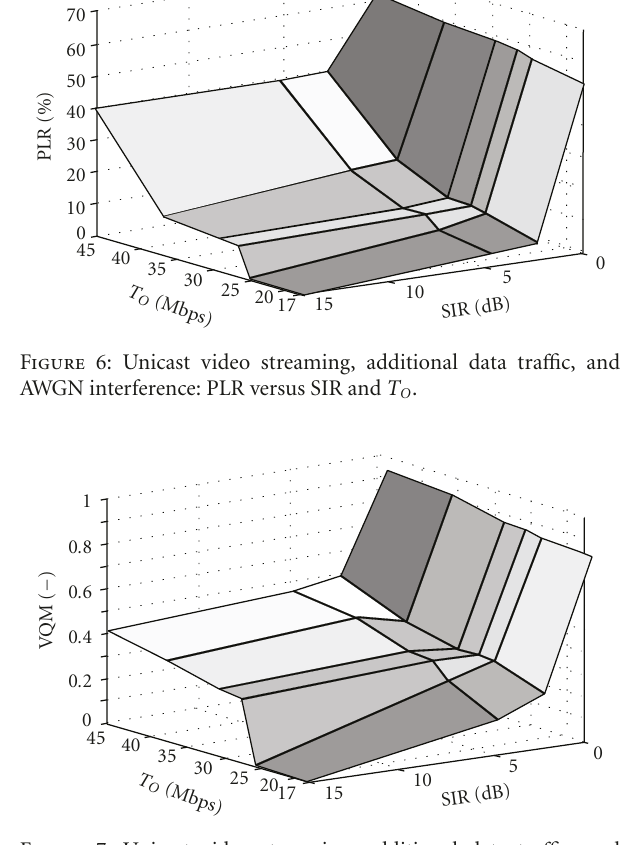
Figure 7: Unicast video streaming, additional data tra ffi c, and AWGN interference: VQM versus SIR and T O